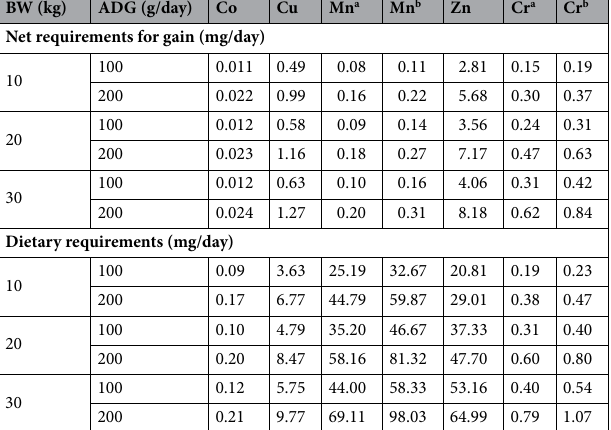
Table 6. Net trace mineral requirements for gain and total dietary requirements of intact and castrated male Santa Ines hair sheep. BW body weight, EBW empty body weight, ADG average daily gain. a Intact male; b castrated male.